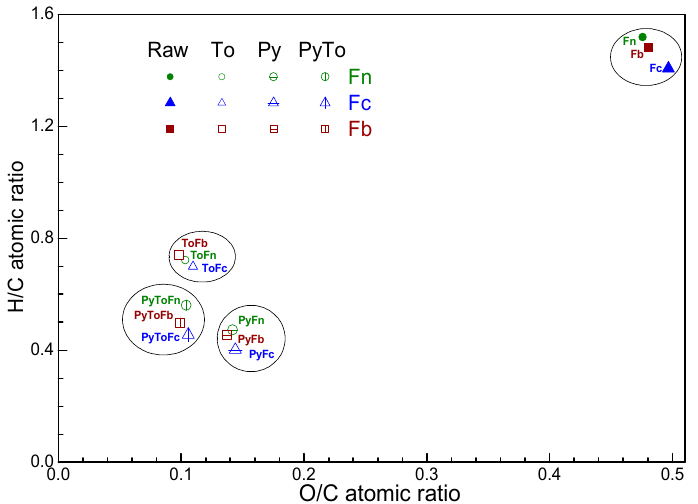
Figure 4. Position in the Van Krevelen diagram of the fir needles, cones and bark before and after thermal processing by torrefaction and/or pyrolysis.